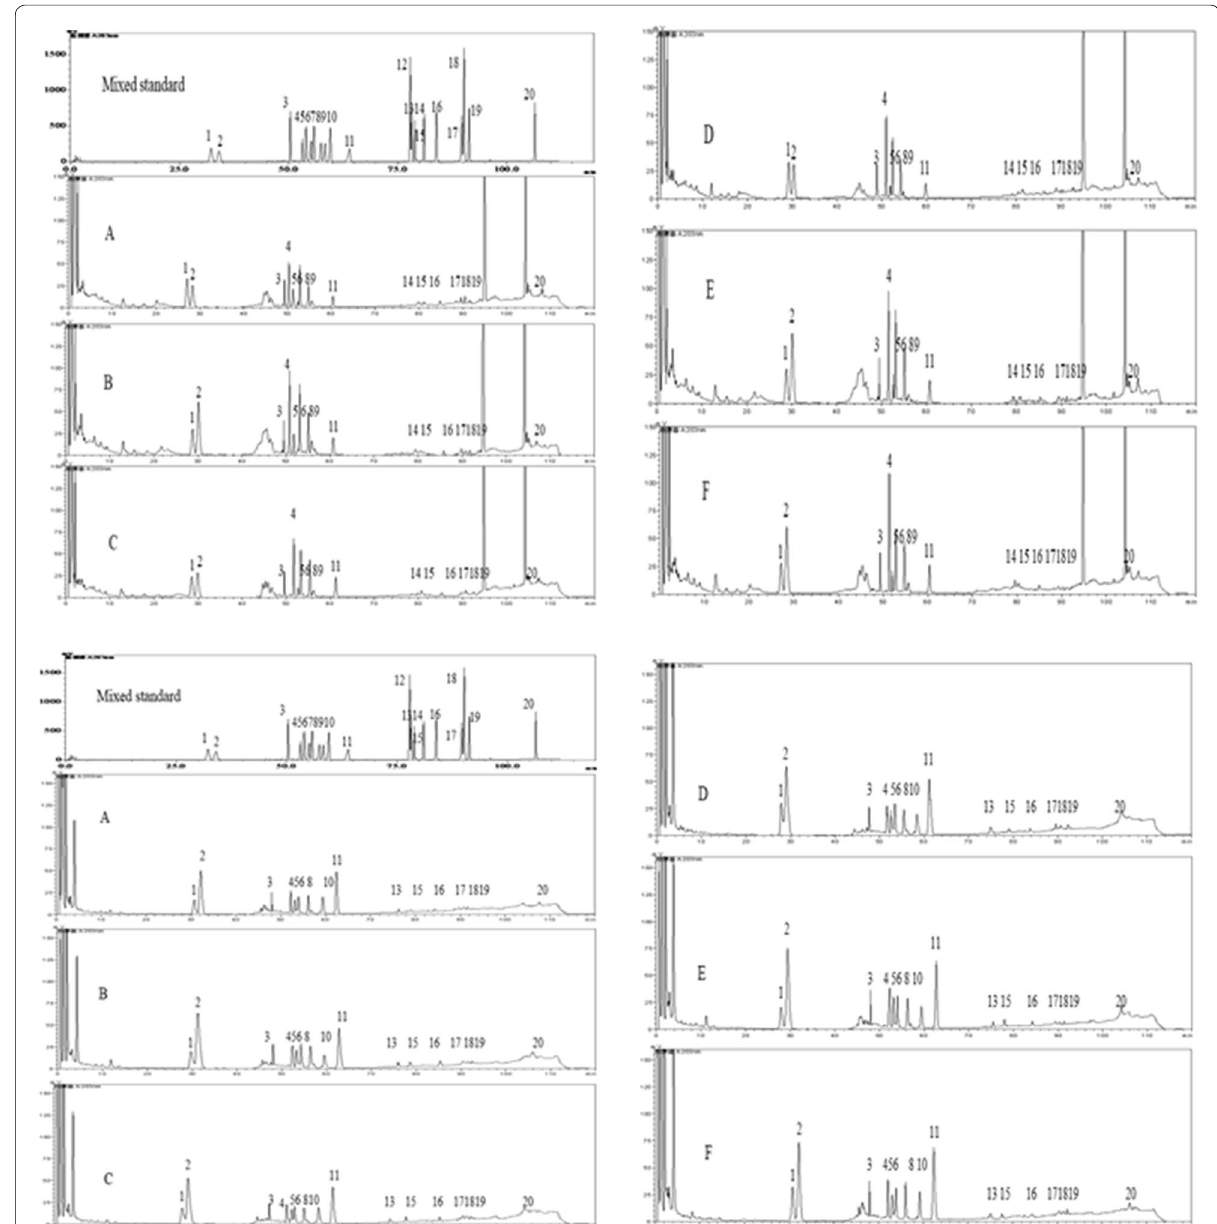
Fig. 5 Mixed standard and ginseng root and leaf samples HPLC chromatogram. 1–20 are ginsenoside Rg1, Re, Rf, Rb1, Rg2, Rc, Rh1, Rb2, Rb3, F1, Rd, Rk3, F2, Rh4, Rg3, Protopanaxatriol, Compound K, Rg5, Rh2, Protopanaxadiol. A, Clear water control group; B, PDB group; C, PDB control group (without bacteria solution); D, Four kinds of trace elements PDB control group (without bacterial liquid); E, Four kinds of trace element compound + PDB Group; F, Four kinds of trace elements compound wheat soybean meal + +